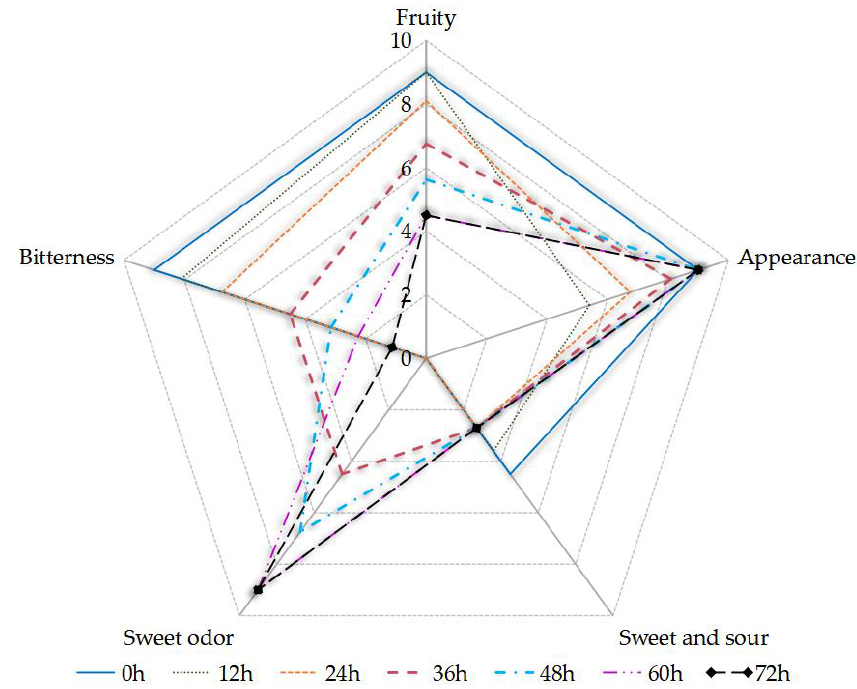
Figure 3. The sensory evaluation of the sea buckthorn juice during fermentation.